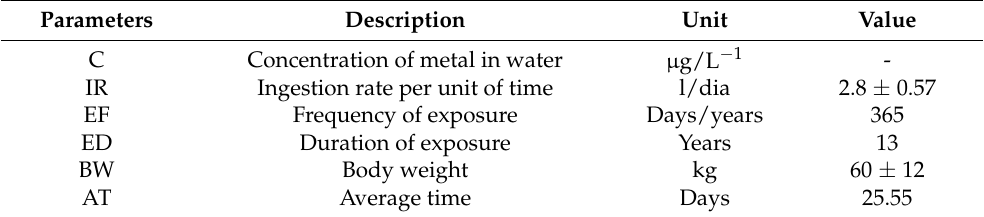
Table 3. Input parameters to characterize the ADD value (exposure parameter).